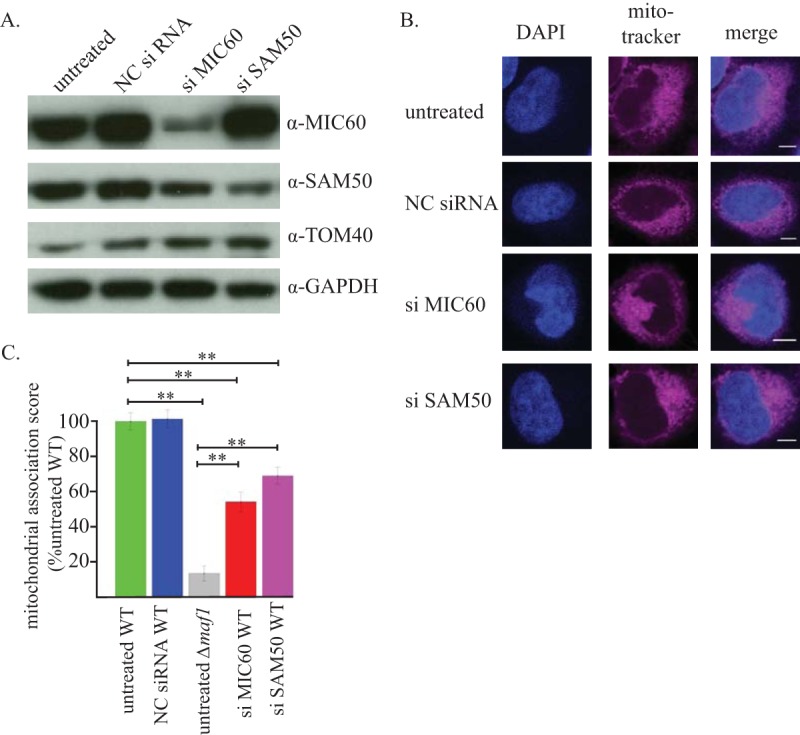
Knockdown of MIB complex components reduces mitochondrial association. (A) Western blot analysis of knockdown efficiency. Total cell lysates 72 h after HeLa transfection with siRNAs were analyzed by SDS-PAGE and Western blotting. The blot was probed with the indicated antibodies. NC, noncoding scramble siRNA control. (B) Mitochondrial morphology was not obviously altered by the short knockdown of MIC60 and SAM50. The images show uninfected fixed cells stained with DAPI and MitoTracker. Scale bars, 5 μm. (C) Analysis of the proportion of parasite vacuoles that show host mitochondrial association. Each vacuole was scored as follows: 2 for complete HMA (>80%), 1 for partial HMA (~80 to ~10%), or zero for no HMA (<10%). An investigator blind to sample identity scored 65 vacuoles per condition over two coverslips; scores were normalized, setting the average score for wild-type parasites infecting untreated cells as 100. **, P < 0.001 in pairwise comparisons. The difference in recruitment scores between the SAM50 and MIC60 siRNA treatments was not statistically significant. This experiment was repeated independently twice with similar results; one representative experiment is shown.